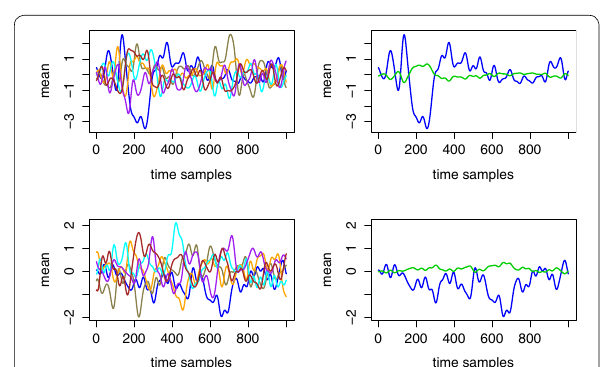
Fig. 3 Exemplary mean traces for different tag (left) and PIN (right) values. Top: User 8, Electrode P7. Bottom: User 6, Electrode